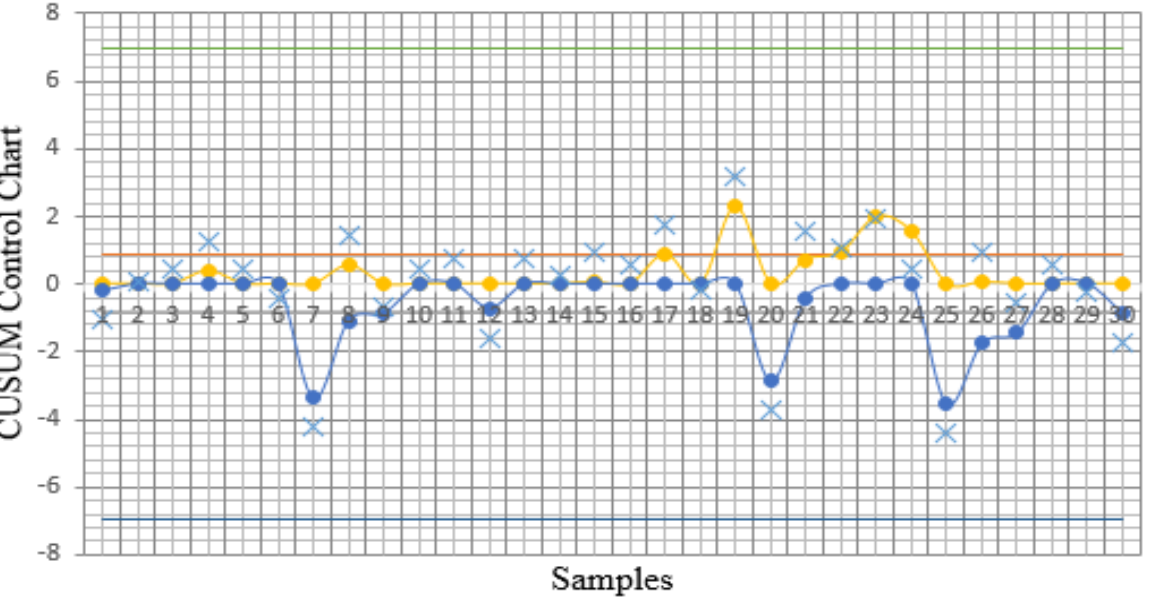
Figure 4. CUSUM chart in the water bottle production in AMWC. Table 2. Initial parameters and their values in the case study.